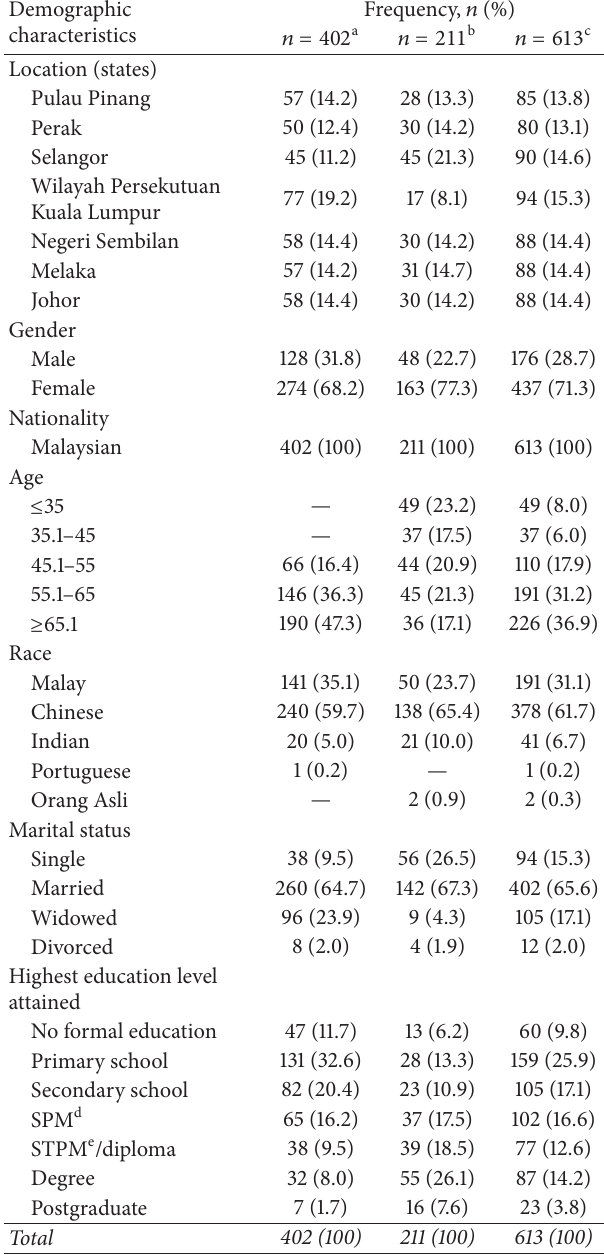
Table 1: Demographic characteristics of self-care adults and infor- mal